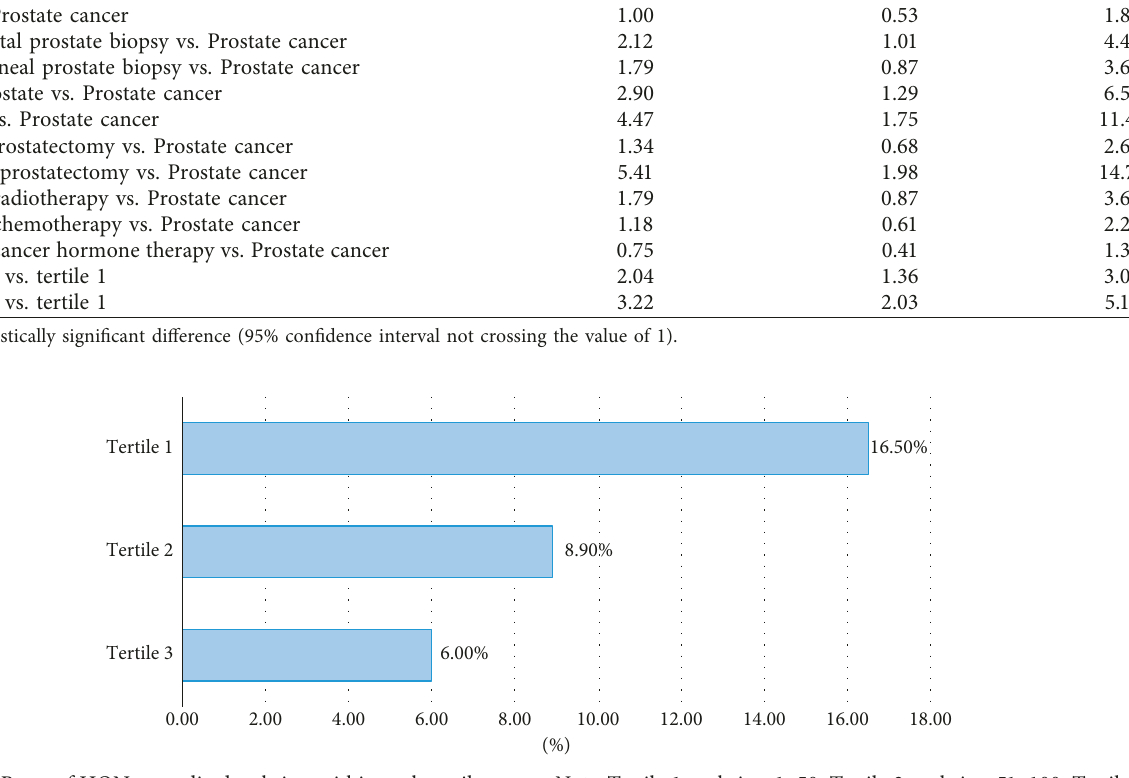
Figure 1: Rates of HON-accredited websites within each tertile group. Note. Tertile 1, websites 1–50; Tertile 2, websites 51–100; Tertile 3, websites